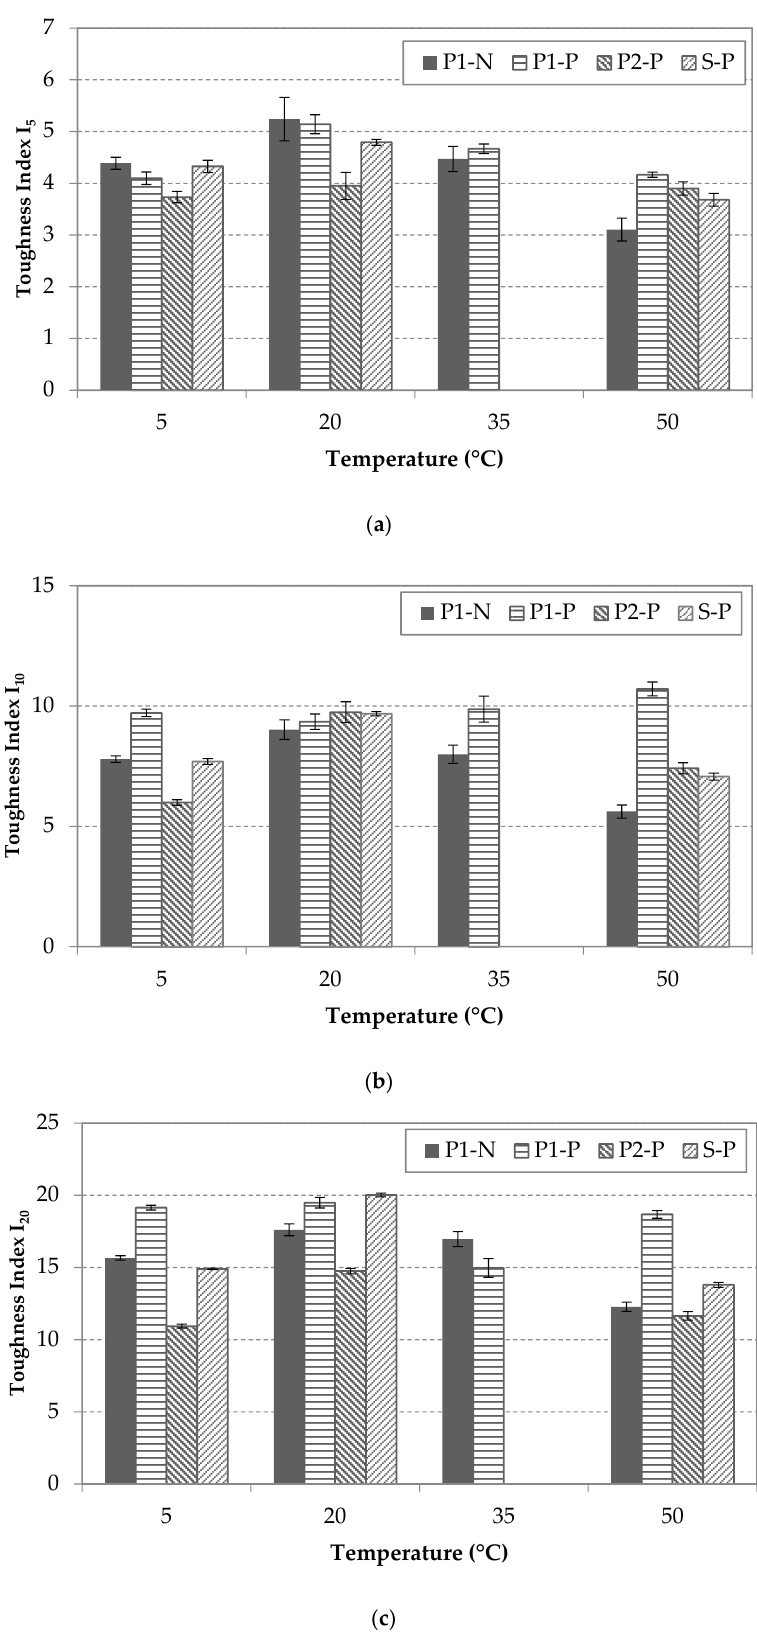
Figure 11. Results of toughness: ( a ) Index I 5 , ( b ) Index I 10, and ( c ) Index I 20 for each type of fiber and condition at different temperatures.